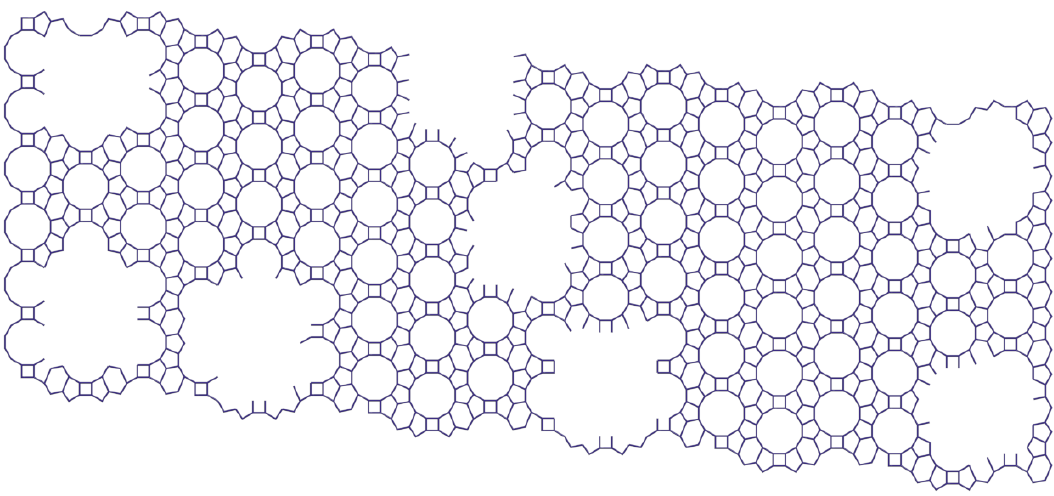
Figure 17. The model structure of sample 2 [compiled by the authors].